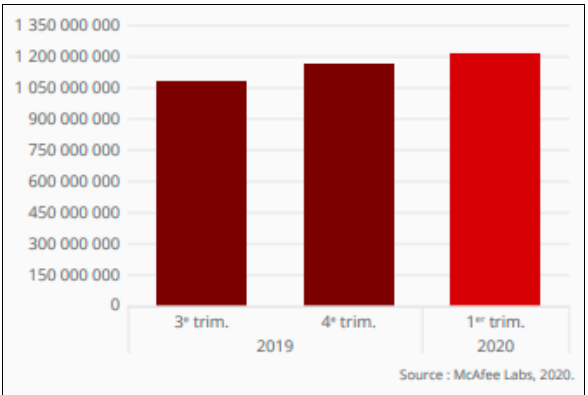
Figure 1. Augmentation of the total number of